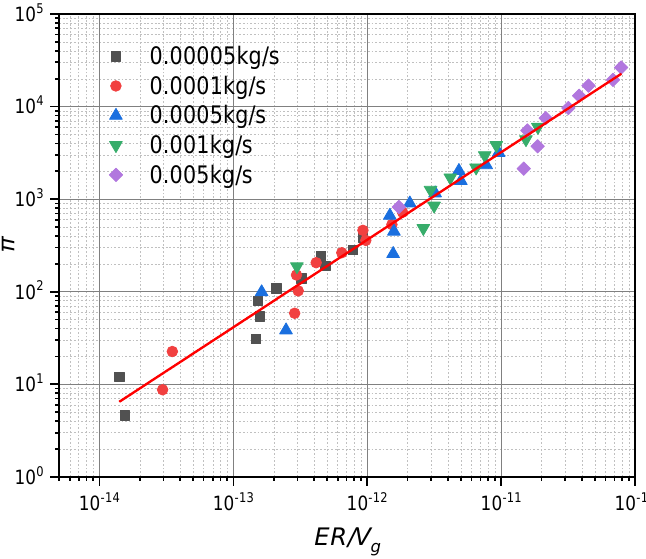
Figure 14. Relationship of π versus dimensionless erosion ratio.